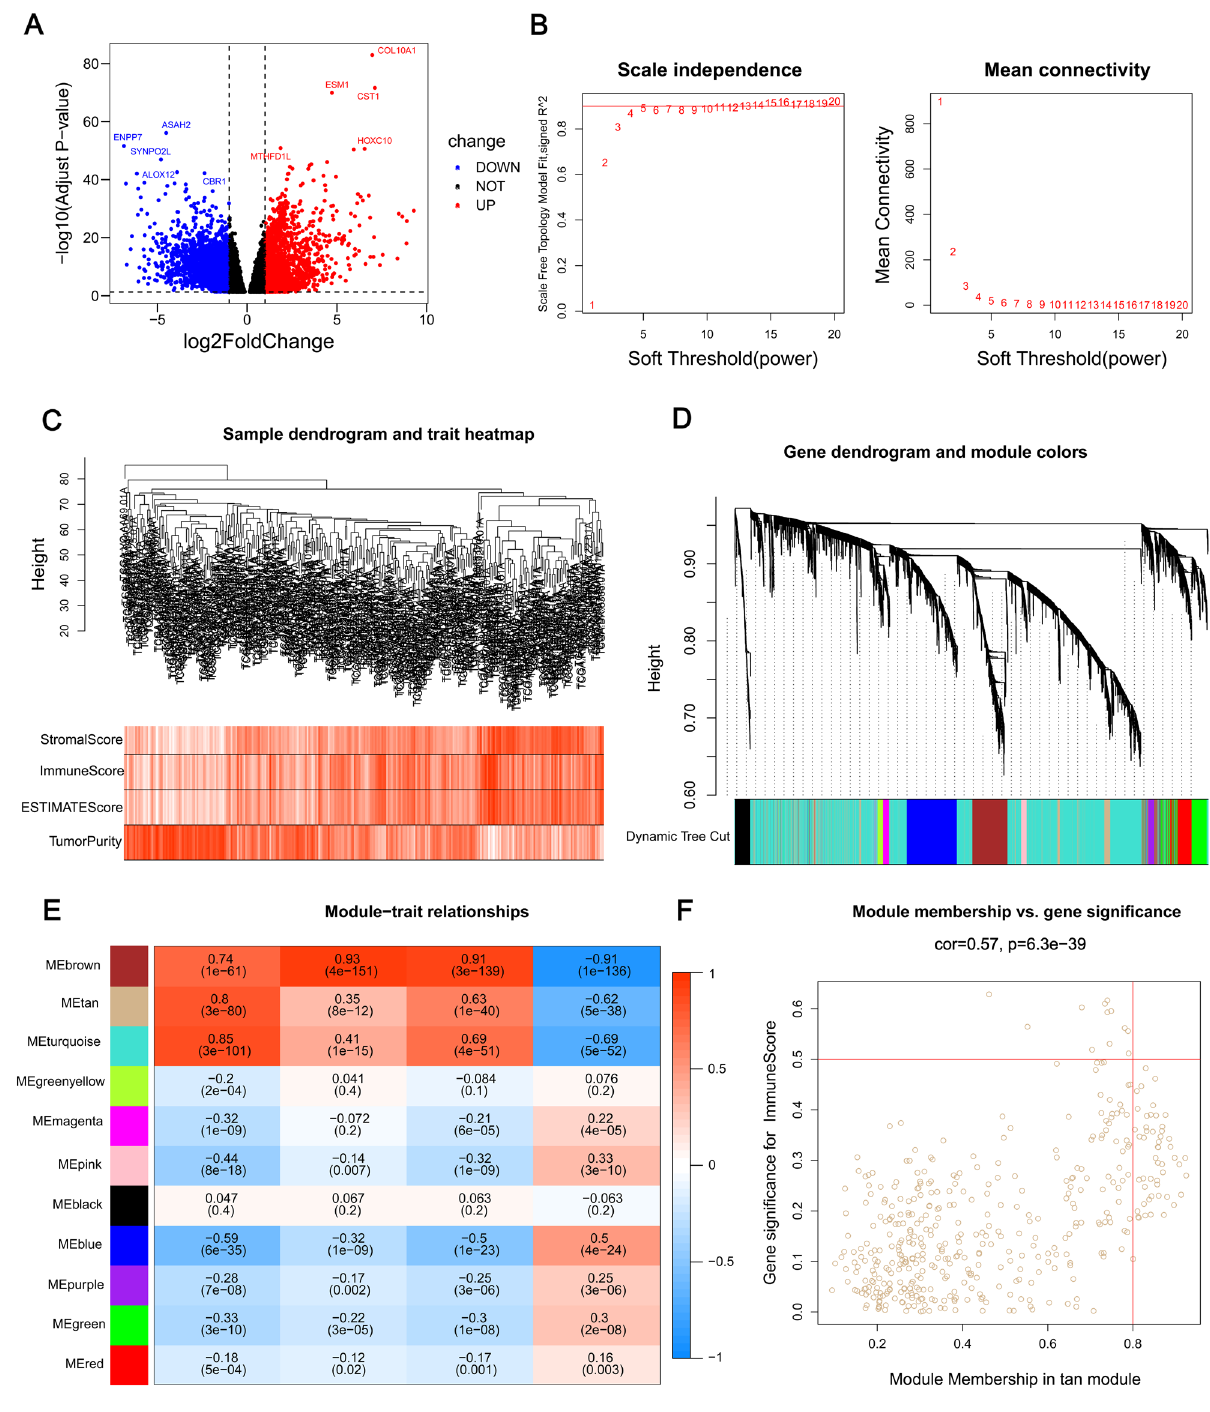
Figure 1. Identification of module genes associated with both clustering and immunity in the WGCNA. ( A ) Volcano plot of differential analysis. ( B ) Analysis of network topology for soft powers. ( C ) Differential genes dendrogram and trait heatmap. ( D ) Dendrogram and genes module colors. ( E ) Heatmap between module eigengenes and ESTIMATE results. ( F ) Scatter plot of module eigengenes in the tan module. The figures were created by R4.1.2 (https:// www.r- proje ct.